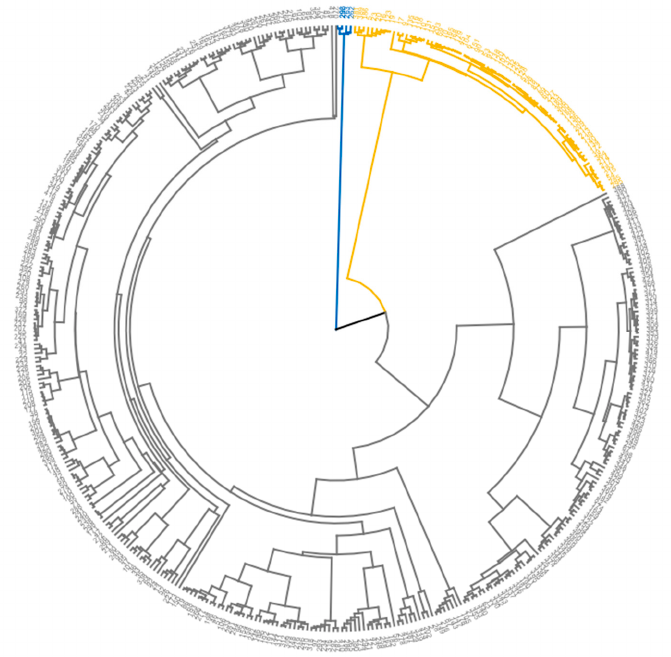
Figure 9. Dendrogram showing the grouping of accessions. Grey, yellow, and blue colors represent Clusters 1, 2, and 3, respectively.